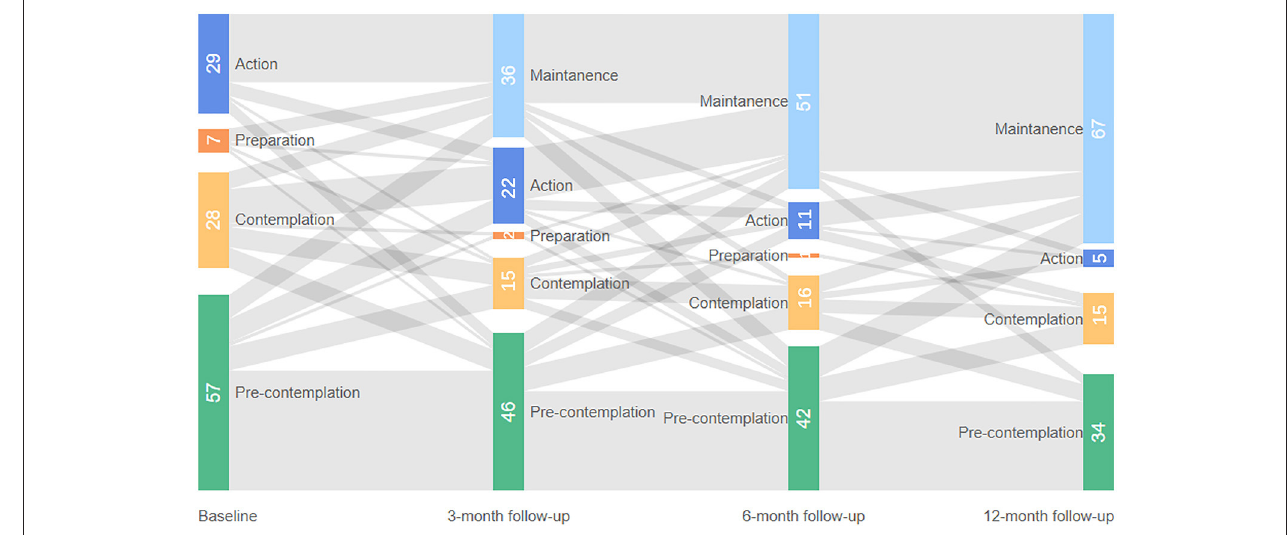
FIGURE 3 | Stage of change for medication taking at all time points in the intervention group.